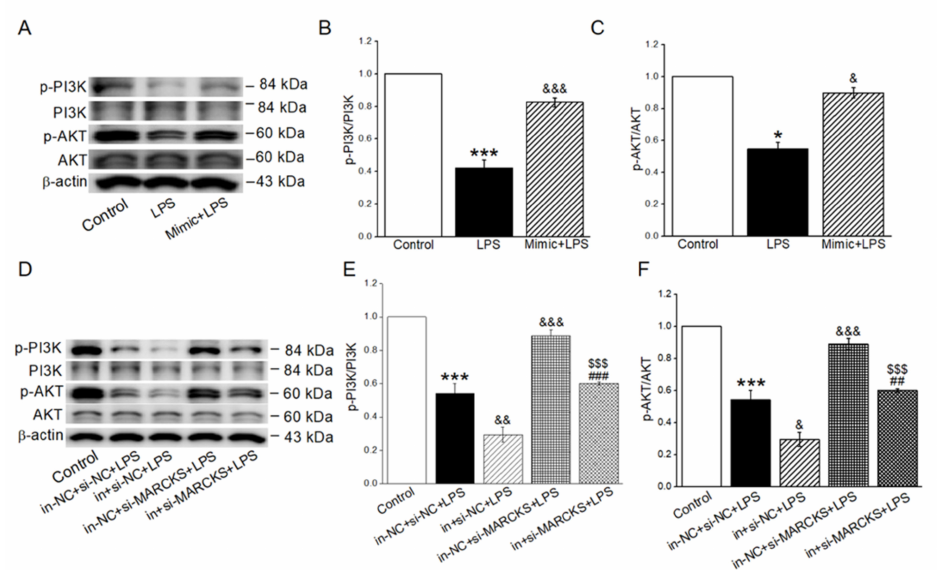
Figure 7. MiR-34c activated the inhibition of PI3K/AKT signaling pathway in LPS-treated cells. ( A ) Representative Western blot bands of p-PI3K/PI3K and p-AKT/AKT in LPS-treated H441 cells transfected with miR-34c mimic. ( B , C ) Graphical representation of data obtained from Western blot as- says for p-PI3K/PI3K and p-AKT/AKT. Bands were quantified by using gray analysis (p-PI3K/PI3K and p-AKT/AKT) ( n = 4). ( D ) Representative Western blot bands of p-PI3K/PI3K and p-AKT/AKT in LPS-treated H441 cells transfected with miR-34c inhibitor and si-MARCKS. ( E , F ) Graphical rep- resentation of data obtained from Western blot assays for p-PI3K/PI3K and p-AKT/AKT. Bands were quantified by using gray analysis (p-PI3K/PI3K and p-AKT/AKT) ( n = 4). Note: * p < 0.05, *** p < 0.001, compared with Control; & p < 0.05, && p < 0.01, &&& p < 0.001, compared with LPS and in-NC + si-NC + LPS; ## p < 0.01, ### p < 0.001, compared with in + si-NC + LPS; $$$ p < 0.001, compared with in-NC + si-MARCKS +